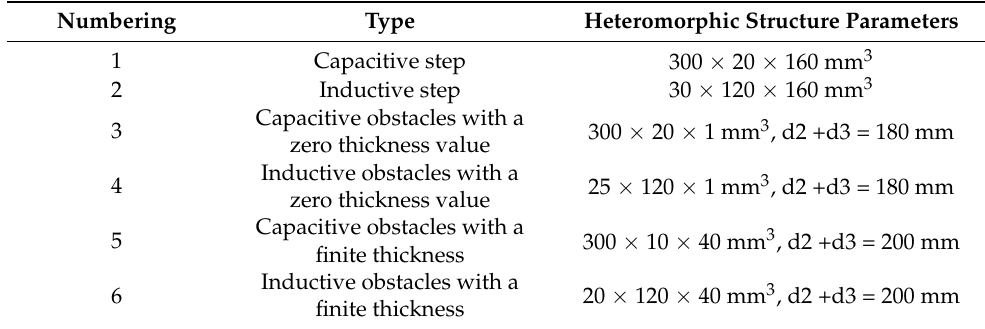
Table 1. The parameters of six irregular structures.